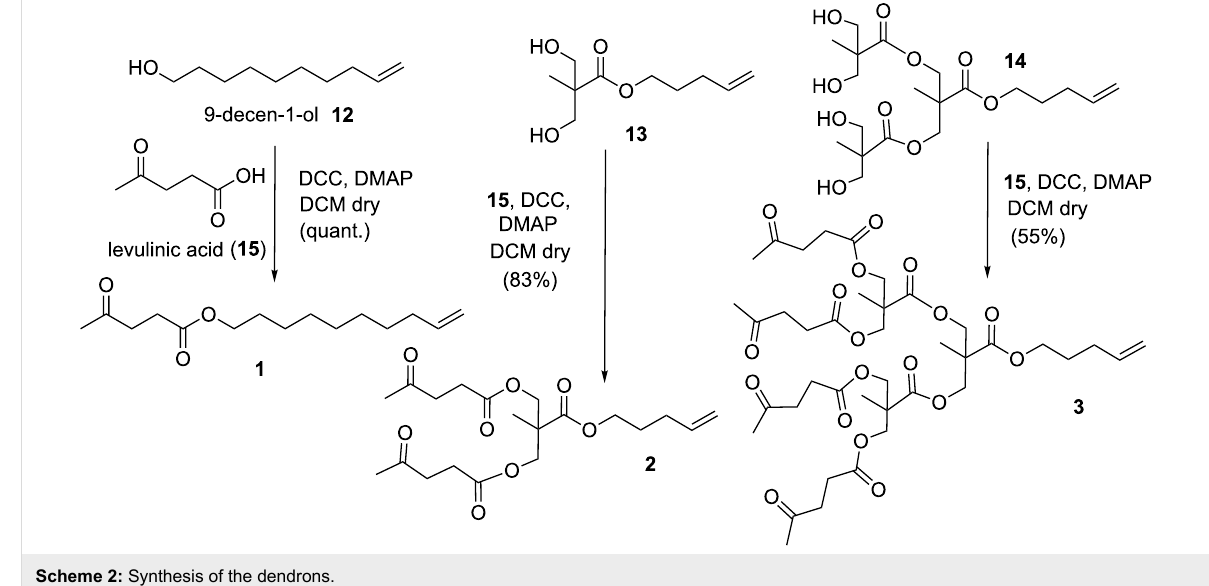
Scheme 2: Synthesis of the